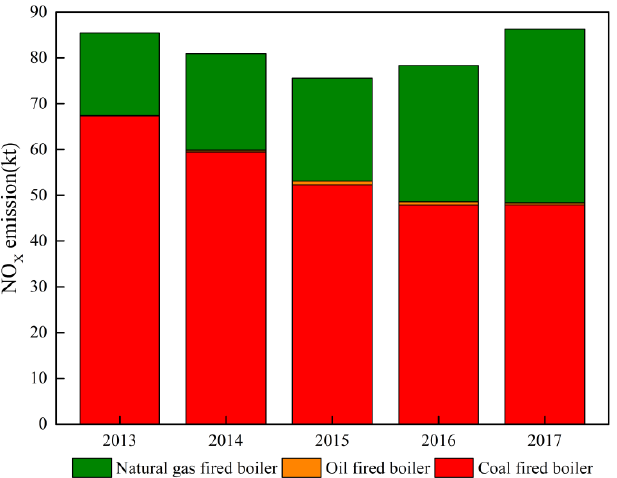
Figure 10. Trends in NO X emission from fuel-based industrial combustion.